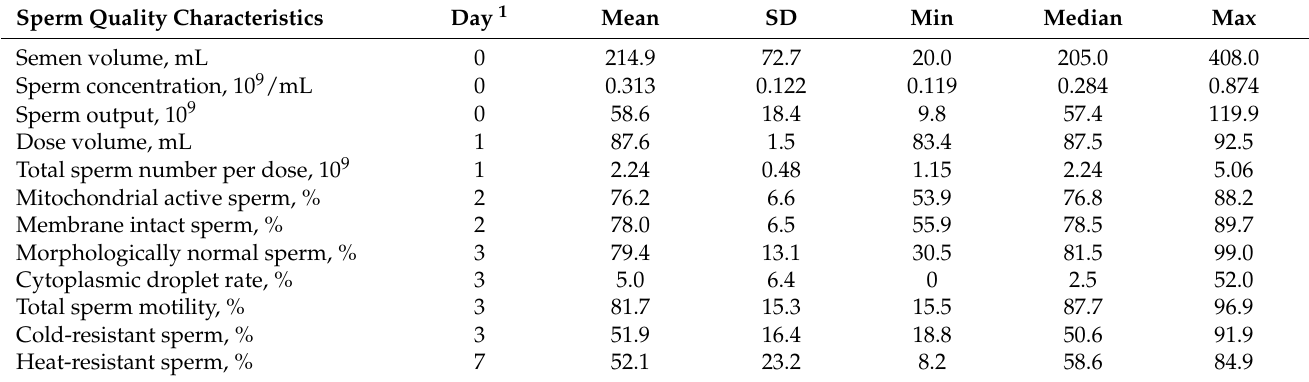
Table 1. Descriptive statistics of semen-related factors ( n = 260 ejaculates, two per boar).